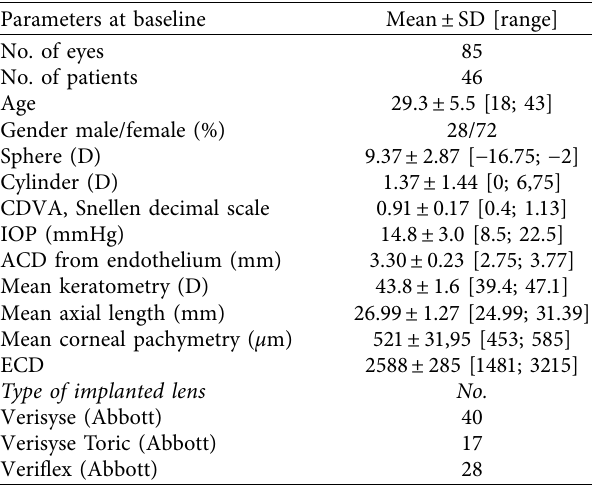
Table 1: Baseline characteristics of patients. Parameters at